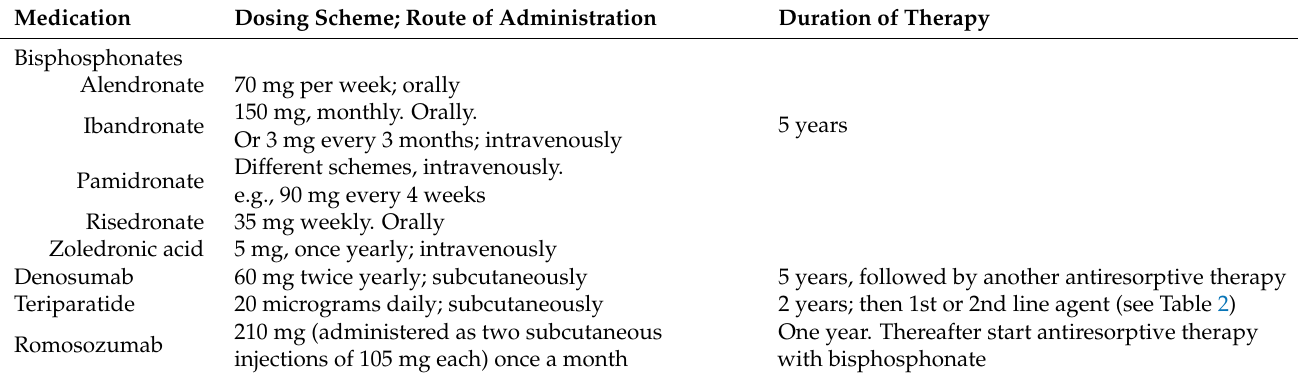
Table 3. Overview of dosing schemes of medications for osteoporosis in celiac disease